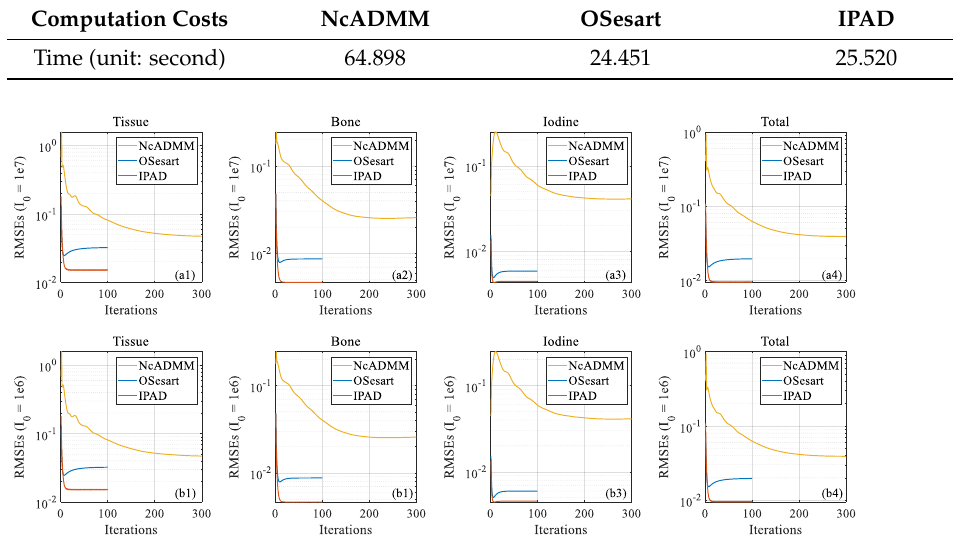
Figure 8. Convergence behaviors of the three iterative algorithms under different noise levels, where the first row represents the RMSEs of noisy data (I 0 = 1 × 10 7 ), and the second row represents the RMSEs of noisy data (I 0 = 1 × 10 6 ). ( a1 – a4 ), and ( b1 – b4 ) represent the RMSEs of tissue, bone, iodine, and total of different methods at two noise levels.